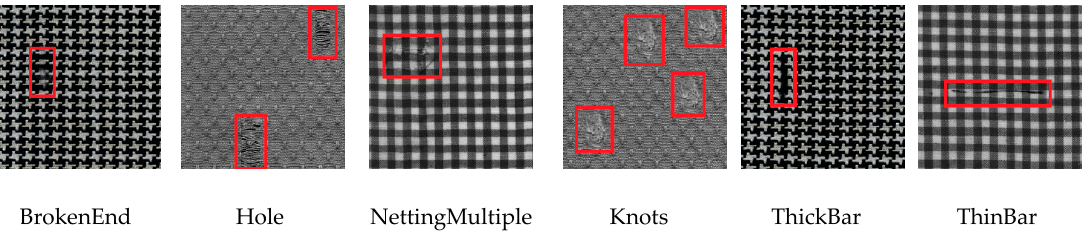
dark thread Figure 7. Illustration of defect images on TILDA dataset. Hong Kong Patterned Textures Database